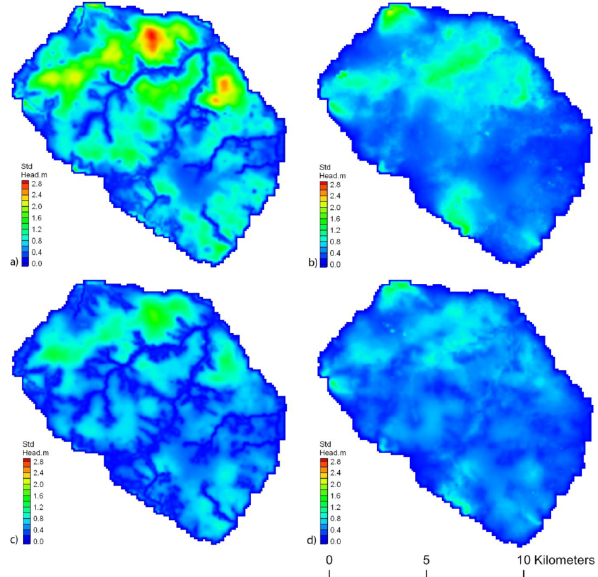
Fig. 6. Standard deviation of groundwater head distribution derived from 90 GeoModel-I models (first row) and from 90 GeoModel-II models (second row). (a) and (c) 1st layer, (b) and (d) 4th layer.